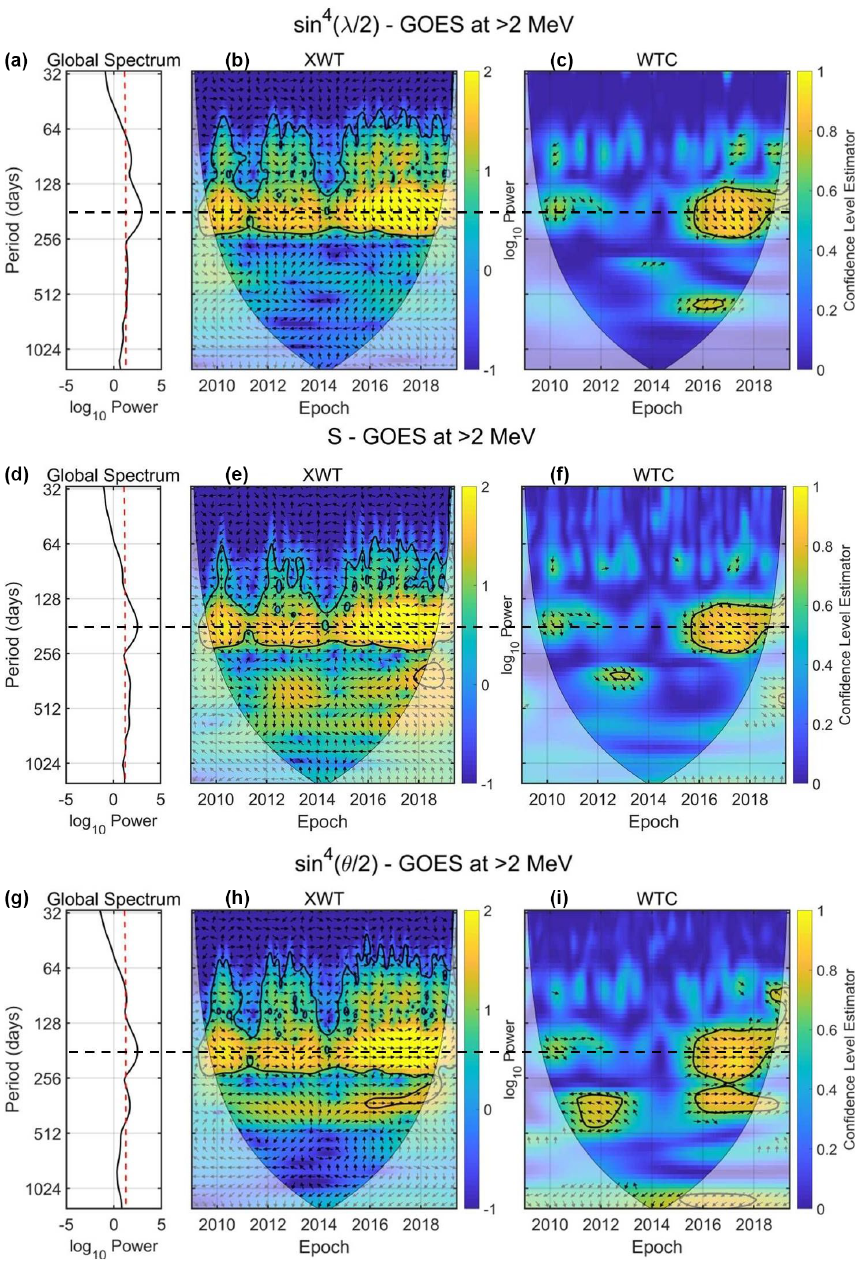
Figure 7. Global wavelet (a, d, g) , cross-wavelet transformation (XWT; b, e, h ) and wavelet coherence (WTC; c, f, i ) between the > 2MeV electron flux from GOES/EPS and the λ function (a, b, c) , the S function (d, e, f) and the θ function (g, h, i) ; the dashed red line corresponds to the 95% confidence level of the global wavelet. The thick black contours mark the 95% confidence level, and the thin line indicates the cone of influence (COI). The color bar of the XWT indicates the log10(power); the color bar of the WTC corresponds to the confidence level of the phase obtained by the Monte Carlo test, and the arrows correspond to a confidence level > 0 . 6. The arrows point to the phase relationship of the two data series in time–frequency space: (1) arrows pointing to the right indicate in-phase behavior; (2) arrows pointing to the left indicate anti-phase behavior; (3) arrows pointing downward indicate that the first dataset is leading the second (meaning that the first dataset occurs earlier in time) by 90 ◦ . The horizontal dashed (black) lines highlight the